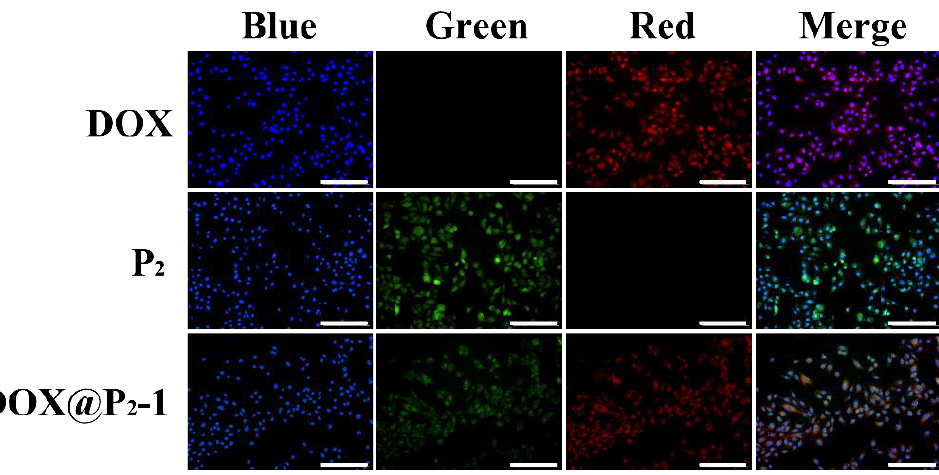
Figure 9. Fluorescence microscopy images of DOX, P, and DOX@P 2 -1 (green for PFONPN moiety) micelles uptake in Bel- 7402 cells (nuclei stained blue with DAPI) (scale bar: 200 μm).